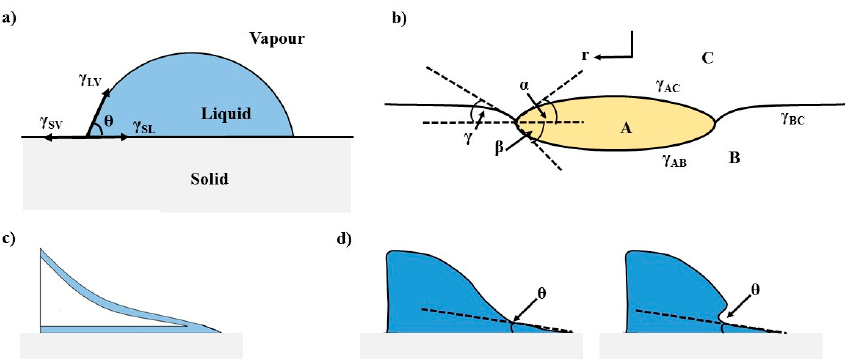
Figure 1. ( a ) Contact angle ( θ ) and interfacial tensions for an axisymmetric dropped onto a solid substrate. ( b ) Contact angles and interfacial tensions for an axisymmetric dropped onto a liquid surface (liquid lens), where A and B represent two liquid phases and C the third fluid (vapor or liquid) . ( c ) Sketch of the liquid profile close to the three-phase contact line at a mesoscopic scale. ( d ) Sketch showing details of the real shape of the drop near the three-phase contact line of the liquid/solid/vapor interface at a mesoscopic scale.